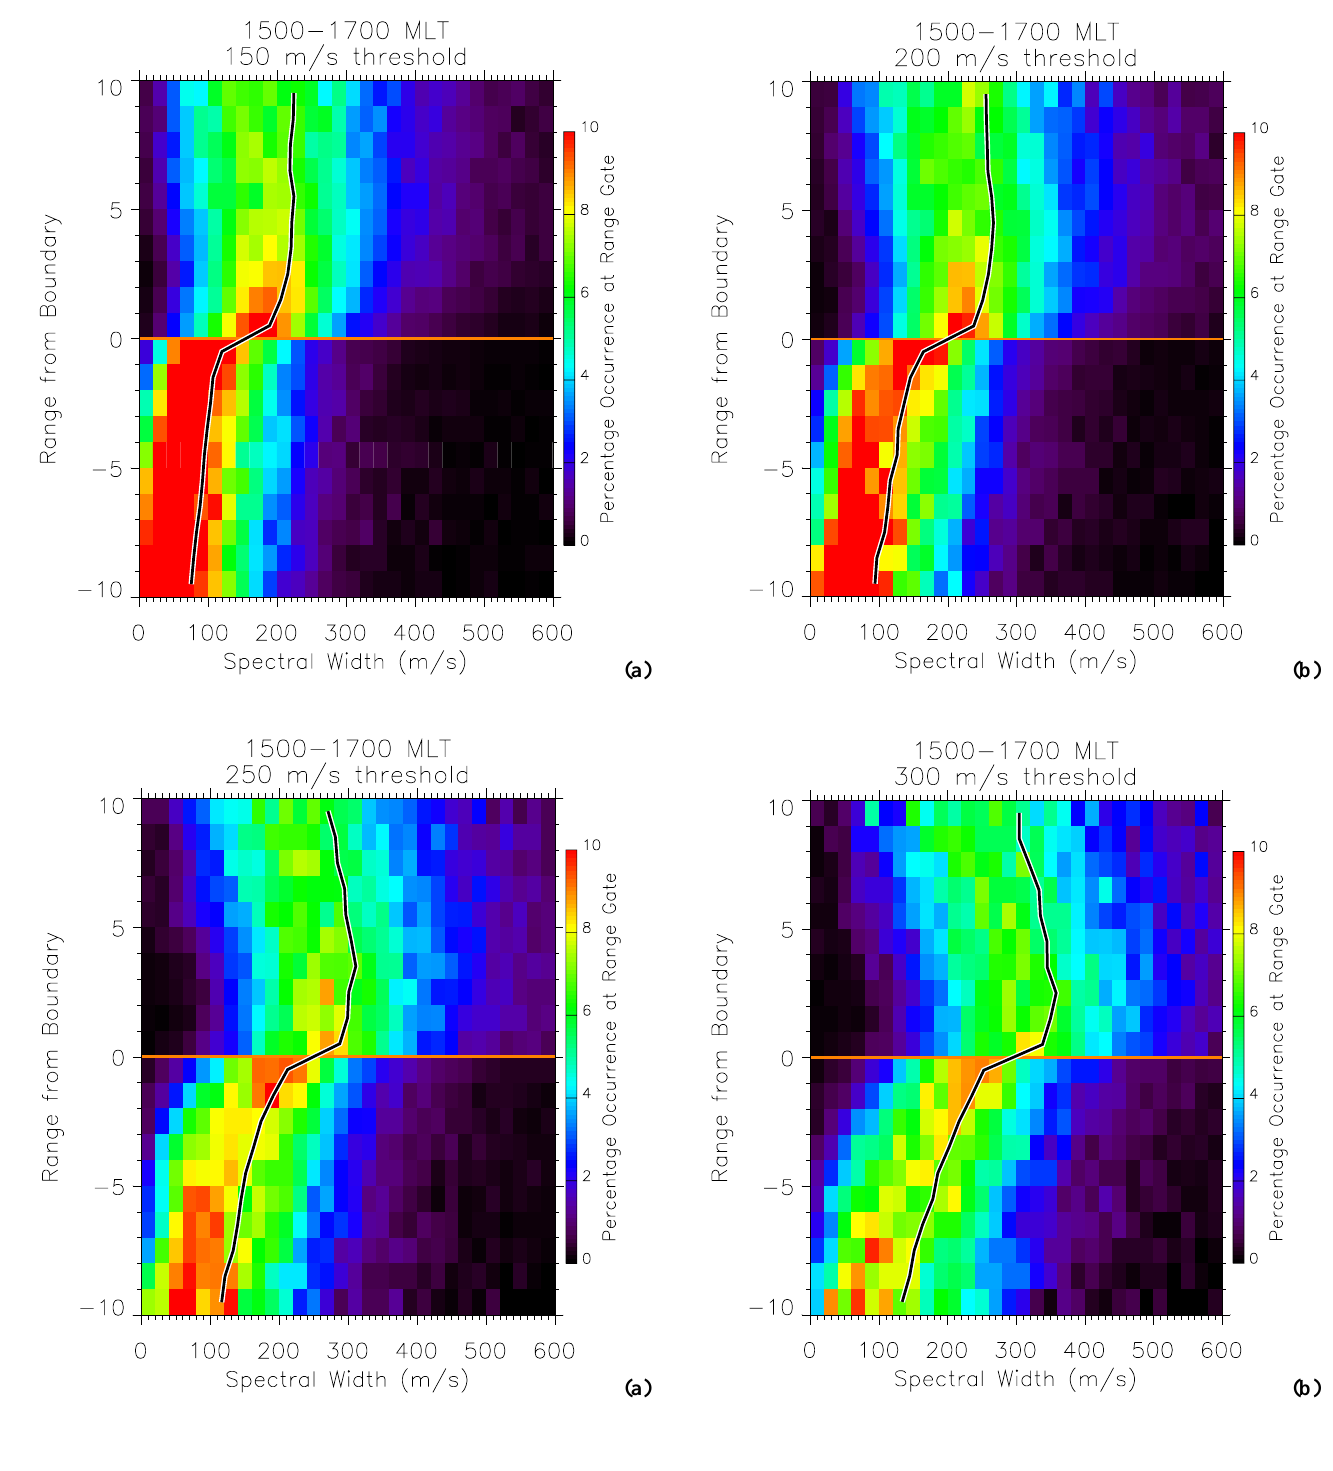
Fig. 9. The distribution of spectral width values ordered by range from the spectral width boundary, determined by applying the C-F threshold technique to 5-years worth of spectral width data from beam 8 of the Halley SuperDARN radar. Only data from the 15:00–17:00 MLT region are shown. The results are presented for four different spectral width threshold values, (a) 150m/s, (b) 200m/s, (c) 250m/s, and (d) 300m/s. The horizontal orange line represents the boundary location. The black on white lines represent the variations of the medians of the distributions with range from the